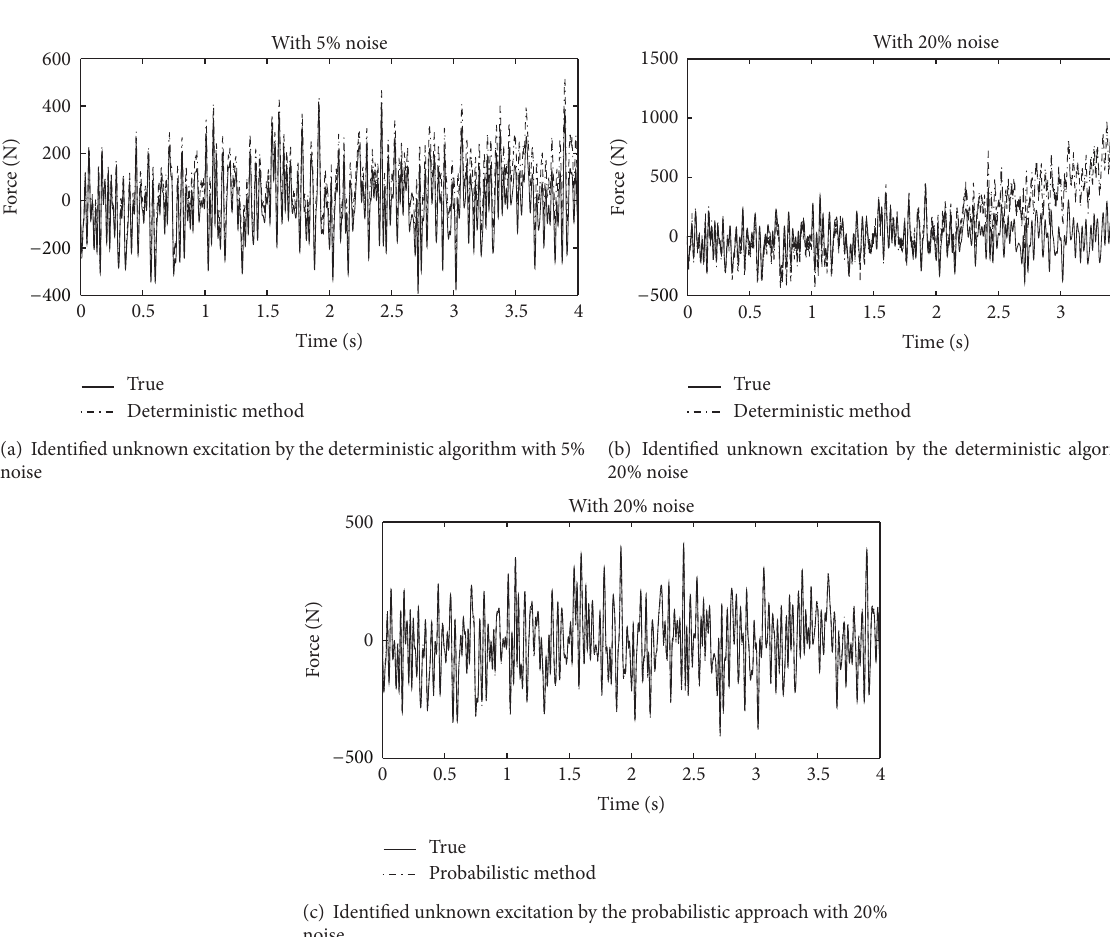
Figure 2: Comparison of identified unknown